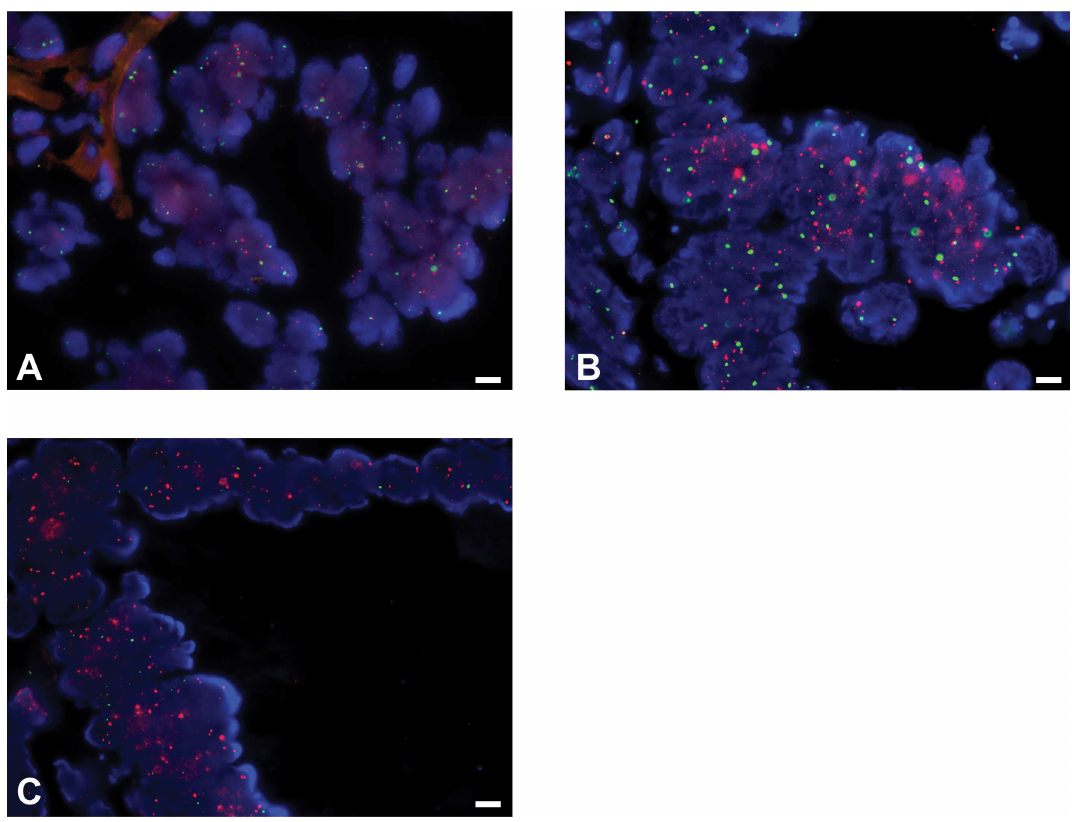
Fig 1. VEGFA copy number status in colorectal cancersmeasuredby fluorescent in situ hybridization. Representative micrographs of (A) diploid,(B) polysomic and (C) amplified VEGFA using fluorescent in situ hybridization (FISH). FISH analysiswas performed using two-colorprobes for VEGFA (red) and internalcontrol (green). Scale bar 20 μ m.